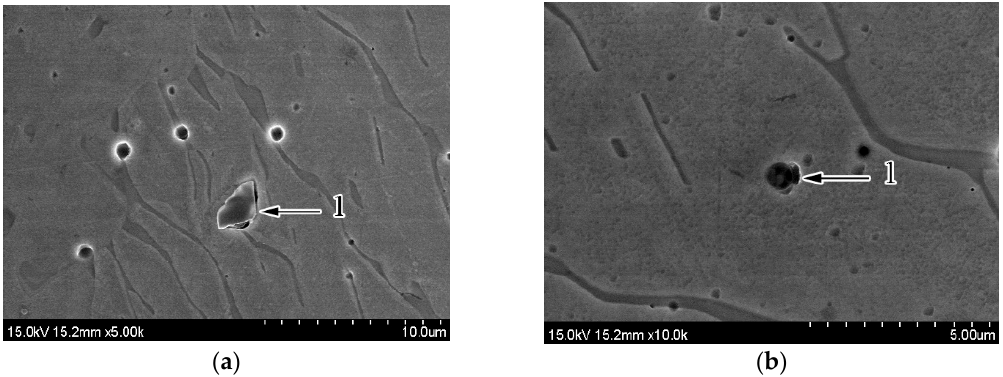
Figure 12. The SEI micrographs of the GTAW+EMS weld: ( a ) Si-rich phase, and ( b ) Al-Si oxide with Sulfur. Table 5. EDS compositional analysis (wt %) of the Si-rich phase in the GTAW+EMS weld. Table 6. EDS compositional analysis (wt %) of the Al-Mn-Si oxide with sulfur in the GTAW+EMS weld.